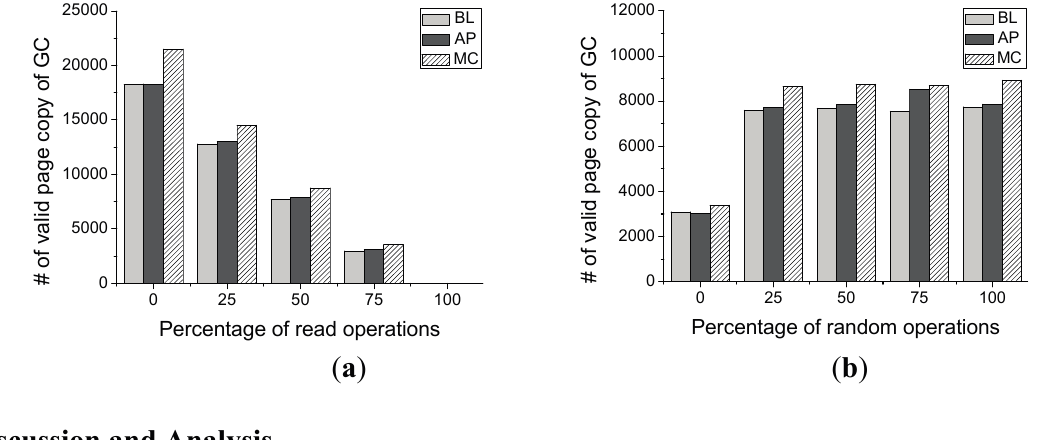
Figure 15. The number of valid page copy operations for Baseline (BL), Meta-Cure (MC), and Asymmetric Programming (AP) during garbage collection operations with different ( a ) Percentages of read operations ( b ) Ratios of random